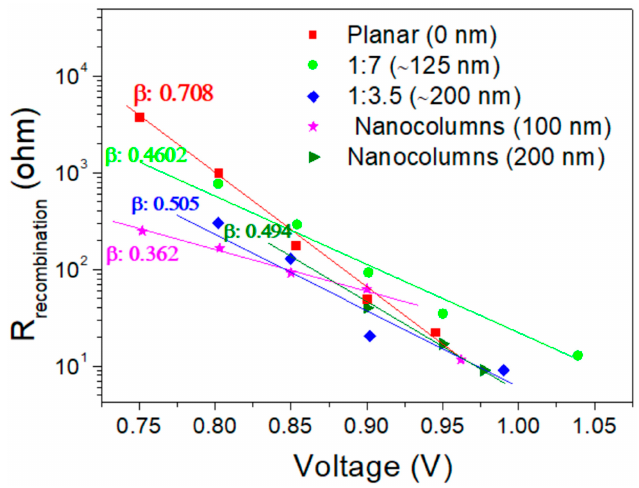
Figure 6. The representative recombination resistances (R recombination ) of the different TiO 2 structures samples determined from IS under different applied bias voltages irradiated with red light. The role of ESL in devices’ degradation was monitored, by recording J-V measurements and incident photon-to-electron conversion efficiencies (IPCE) after 30 days (Figure S5a,b). We found that non-planar devices were more stable than planar ones. IPCE measurements of aged devices showed a systematic depletion of the photo generation in the full-wavelength range. Furthermore, following the methodology of previous works [37,39], we also measured the open-circuit voltage ( V oc ) as a function of temperature (T in K) in order to extract the band gap of aged devices. Figure S6 represents the open-circuit voltage versus temperature curve of aged devices (stored under humid conditions for 30 days), and fits well into the straight line. The activation energy—which gives information about dominant recombination pathway—was estimated by extrapolation of the data to T = 0 K. It can be observed that the calculated band gaps show increment with respect to fresh devices ( E g calculated by means of the absorbance measurements). These results are in accordance with the previous published results [37].